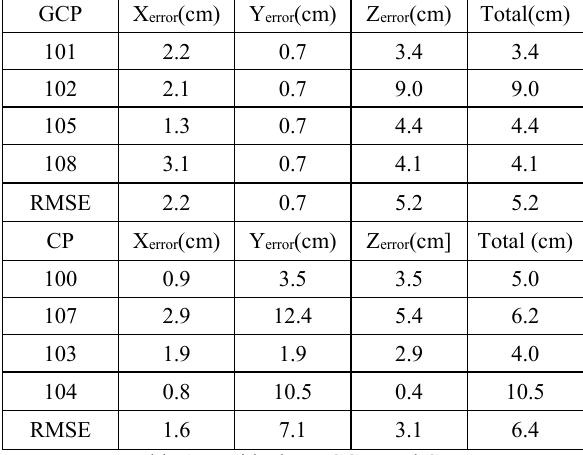
Table 1: Residuals on GCPs and CPs